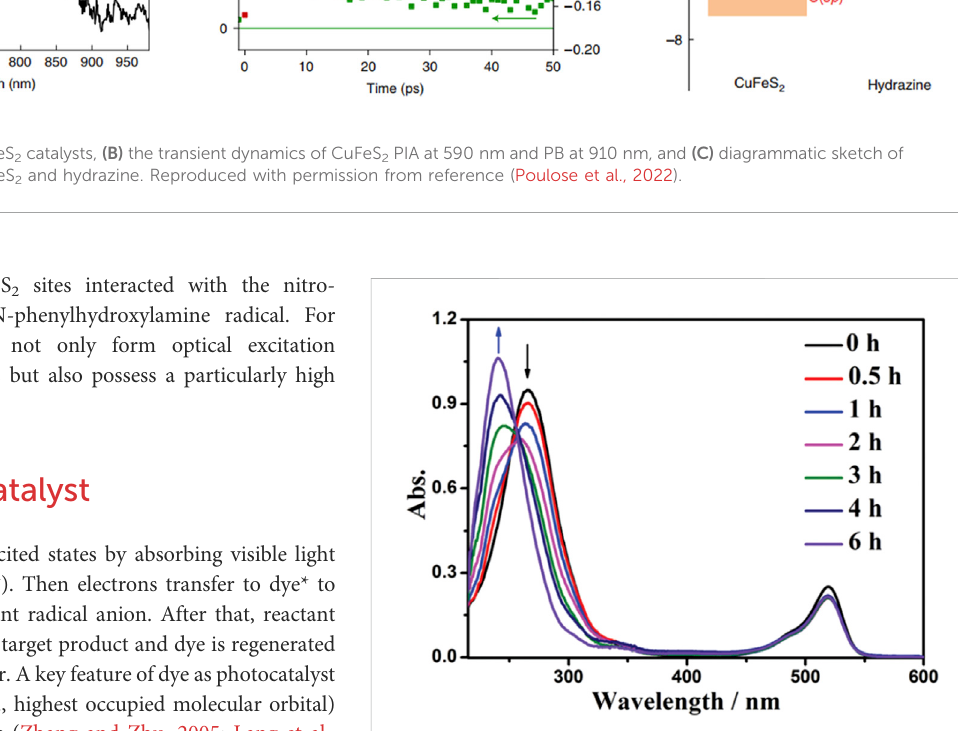
FIGURE 16 Changes of UV-vis absorption spectrum of nitrobenzene solution during irradiation. Reproduced with permission from (Yang et al.,